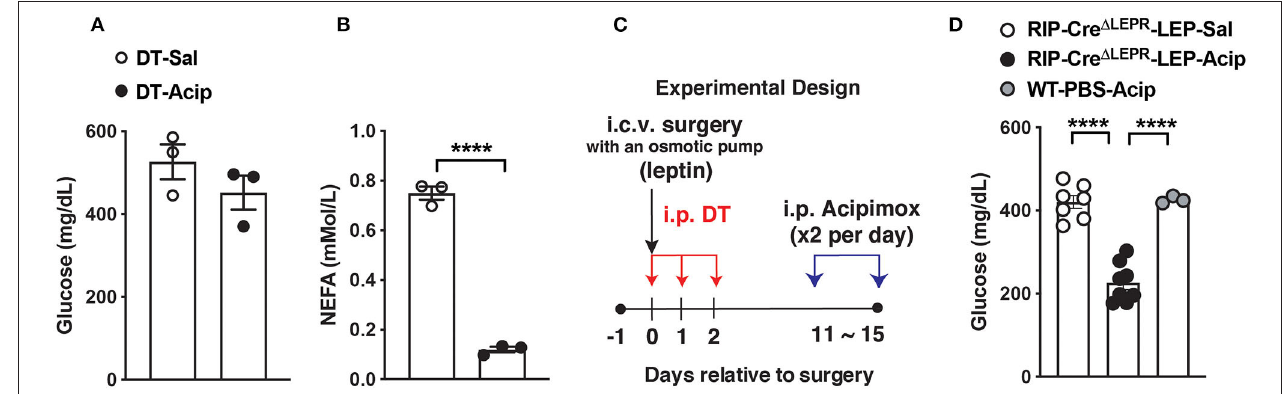
FIGURE 6 | Lowering blood lipids levels reverses hyperglycemia in insulin-deficient RIP-Cre 1 LEPR mice administered leptin. (A) Blood glucose and (B) plasma NEFA ( n = 3; WT-Sal, and 3; WT-Acp) levels in insulin-deficient mice administered Acipimox (WT-Acip) or vehicle (Saline, WT-Sal). RIP-DTR mice were administered DT as described in Figure 1 to induce insulin deficiency. (C) Experimental design for D. (D) Blood glucose level 5 days after i.p. acipimox injection (2 times per day for 5 days at the dose of 100 mg/kg B.W.) into insulin-deficient RIP-Cre 1 LEPR mice chronically administered leptin into the lateral ventricle (25 ng/0.11 µ L/h) (RIP-Cre 1 LEPR -LEP-Acip) ( n = 7; RIP-Cre 1 LEPR -LEP-Sal, 8; RIP-Cre 1 LEPR -LEP-Acip, and 3; WT-PBS-Acip). Control group for i.p., acipimox injection was administered i.p., saline into insulin-deficient RIP-Cre 1 LEPR mice chronically administered leptin into the lateral ventricle RIP-Cre 1 LEPR -LEP-Sal). Control group to determine effects of chronic acipimox injection itself on glucose levels in insulin-deficient mice was WT mice administered i.c.v. PBS and i.p., acipimox (WT-PBS-Acip). Values are mean ± S.E.M. **** p < 0.0001. Unpaired t -test (A,B) and one way ANOVA followed by Tukey’s multiple comparison test (D) were used to analyze the